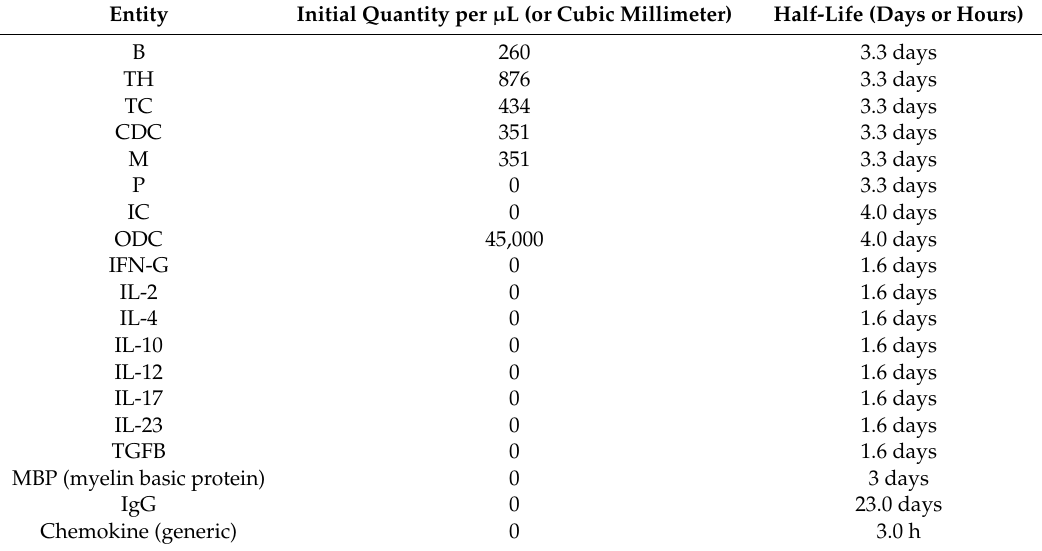
Table 1. Cellular and molecular entities implemented in the simulation framework. Initial quantities and half-life values were retrieved from literature in the field [31]. UISS framework takes into account B cells, TH (CD4 + T cells), TC (CD8 + T cells), conventional dendritic cells (CDC), (macrophages (M), plasma B cells (P cells), immunocomplexes (IC), oligodendrocytes (ODC), interferon gamma (IFN-G), interleukins of type x (IL-x), transforming growth factor beta (TGFB), myelin basic proteins